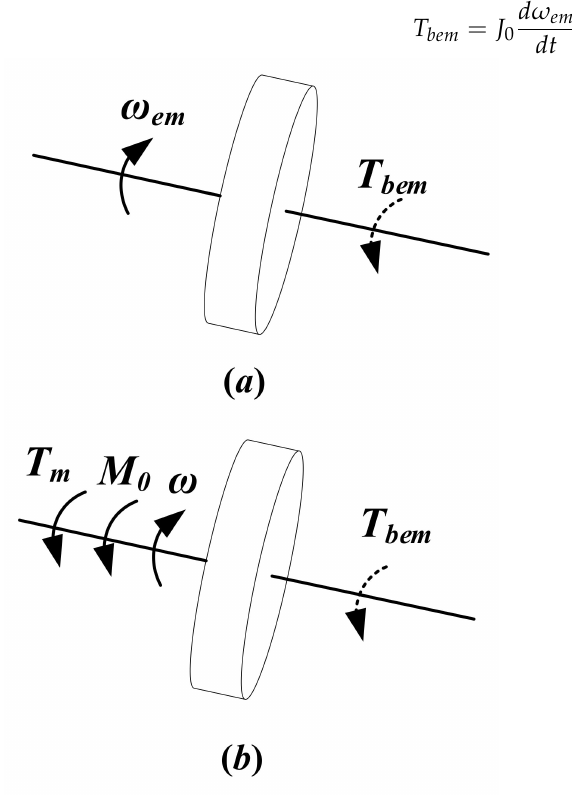
Figure 22. Schematic diagram of the force on the main shaft of the test bench: ( a ) ideal state; ( b ) mixed